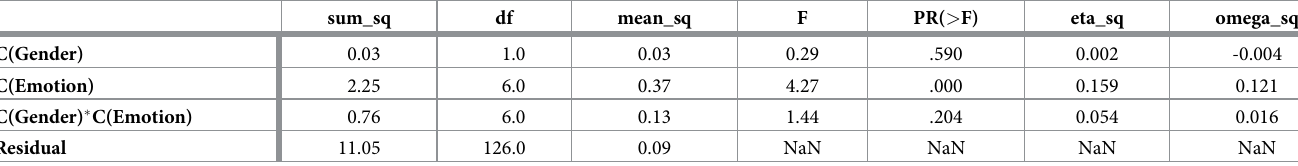
Table 16. Descriptive table for two-way ANOVA for Phase 1(for speaker